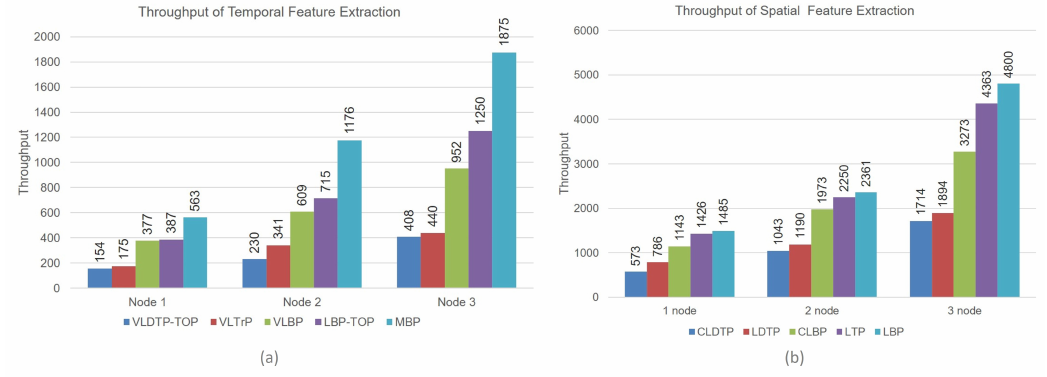
Figure 12. ( a ) Throughput (in seconds) of the temporal feature extraction APIs on STAD dataset and ( b ) throughput (in seconds) of the spatial feature extraction APIs on the STAD dataset.